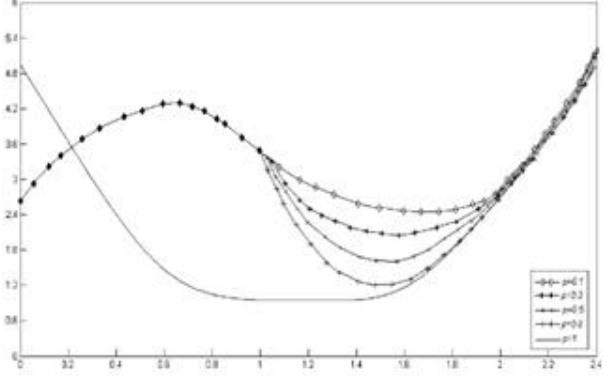
Figure 3. Asymptotic random rate of the between-failures durations according to various values of